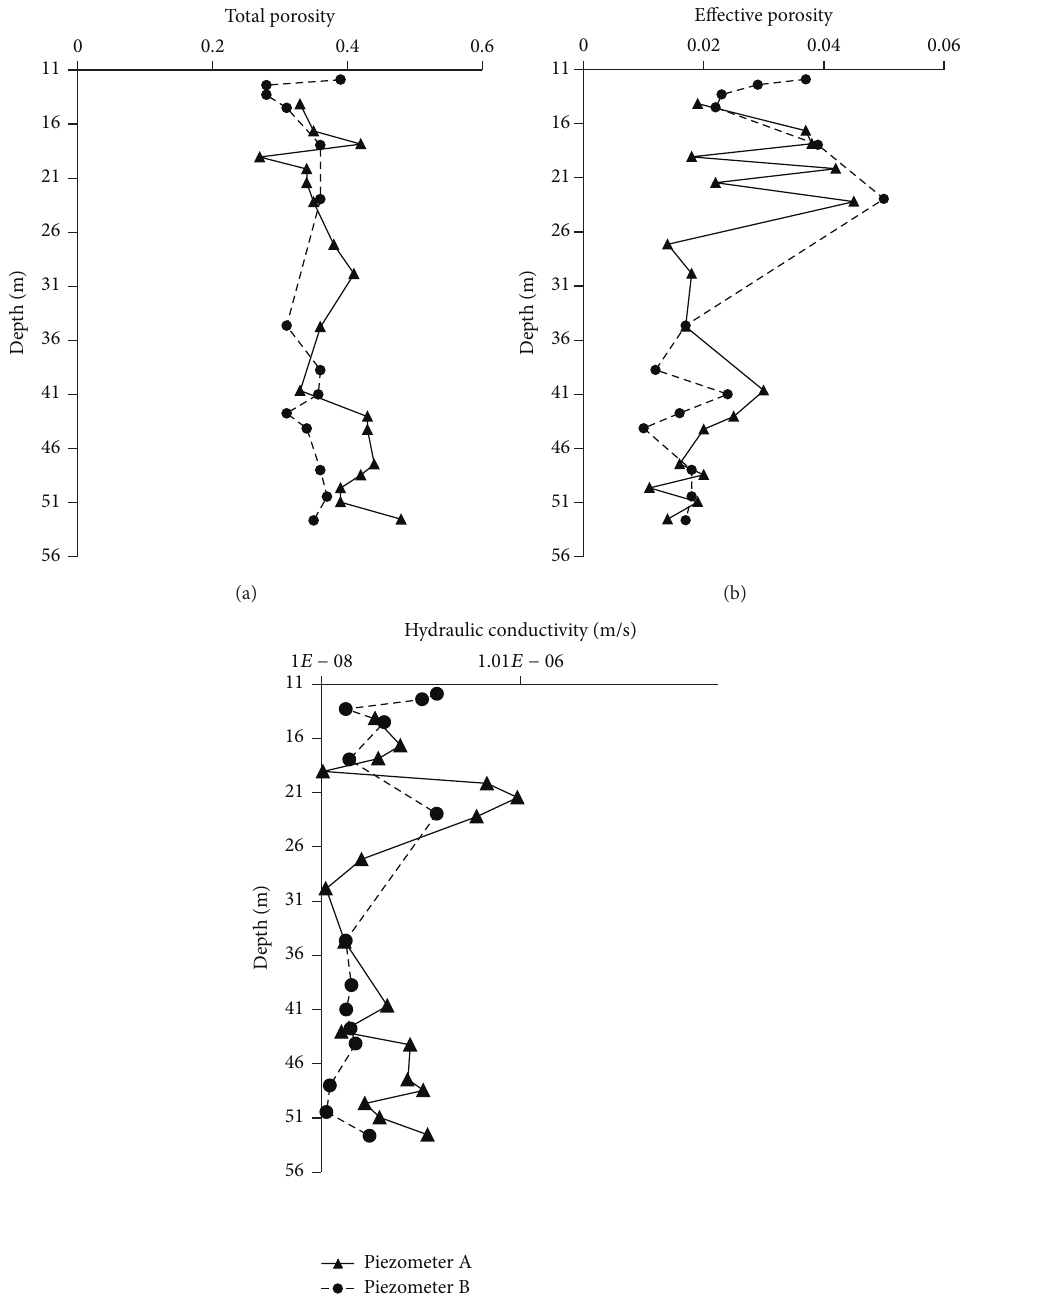
Figure 3: Variation of total porosity (graph a), effective porosity (graph b), and hydraulic conductivity (graph c) with depth, along the drilling columns of piezometers A and